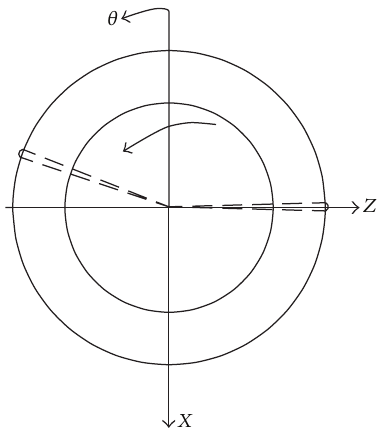
Figure 6: Hz-Up configuration of two-groove oil journal bearing.